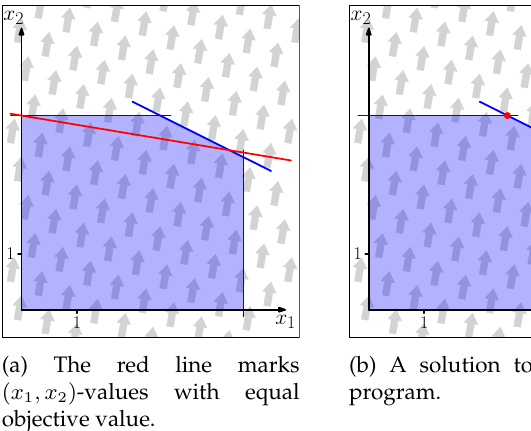
Figure 2: A linear program with variables x 1 and x 2 ; objective is to maximize 6 x 1 + x 2 with respect to x 1 ≥ 0 , x 2 ≥ 0 , 2 x 2 ≤ 7 , 2 x 1 +4 x 2 ≤ 18 and x 1 ≤ 4 . The solution space, i.e., all pairs ( x 1 , x 2 ) for which every given inequality is true, is marked as a blue polytope. The gray arrows in the background indicate the objective. They are orthogonal to the line of equal objective values in